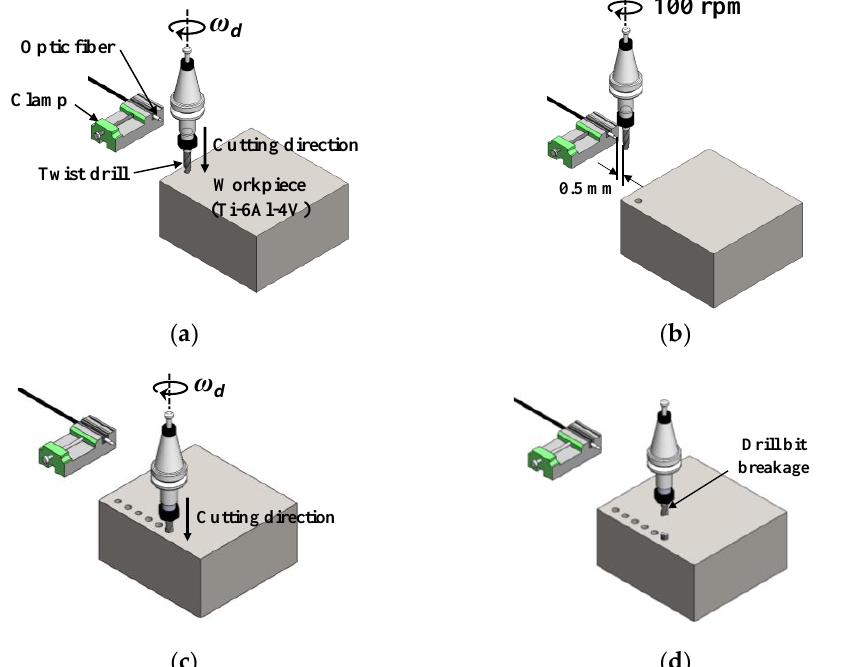
Figure 4. Schematic of the experimental procedure: ( a ) drilling step, ( b ) drill bit checking step, ( c ) drilling step, and ( d ) drill bit breakage.